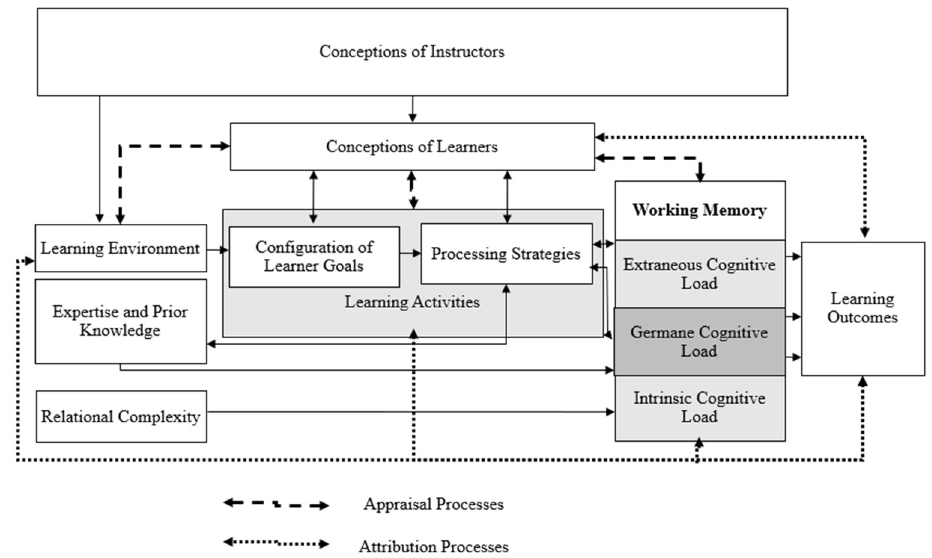
Figure 1. A revised model of self-regulated learning.